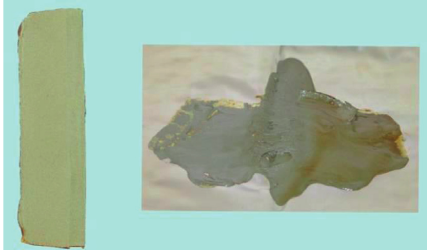
Figure 8: The sketch of structural failure caused by aging and decomposition of NEPE.